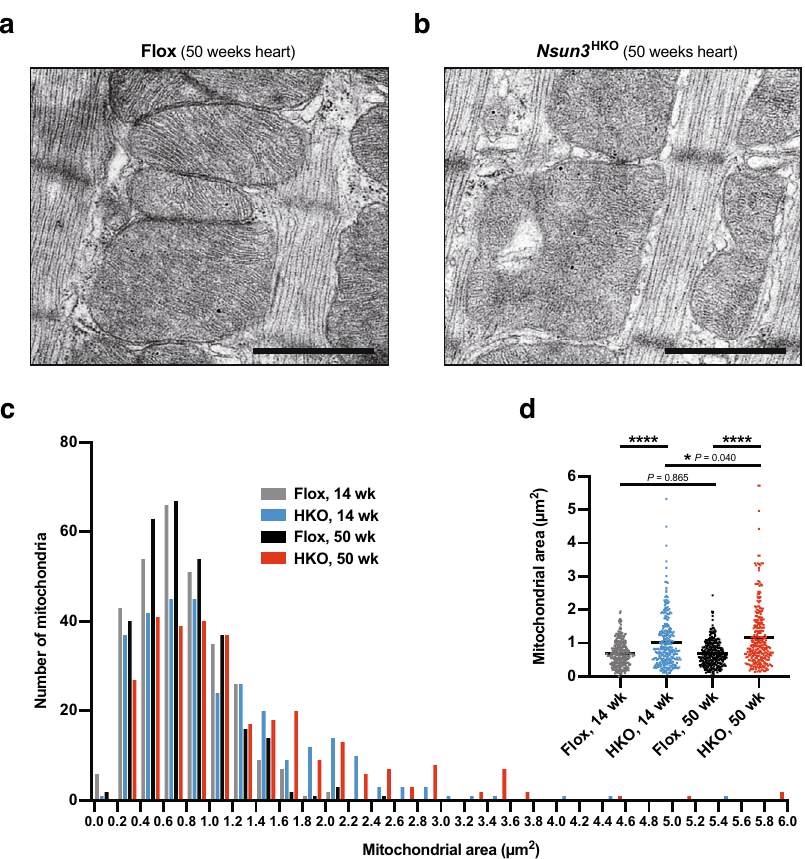
Fig. 4 Morphological abnormalities of Nsun3 HKO mouse heart mitochondria. a , b Representative images of mitochondria in cardiac muscles of 50-week- old Flox mice ( a ) and Nsun3 HKO mice ( b ). Scale bar, 1 μ m. c Histogram showing the size distribution of cardiac mitochondria from 14- or 50-week-old, Flox, or Nsun3 HKO mice. n = 300 mitochondria in each group were analyzed. d Violin plot of the same data as shown in the histogram. The mean mitochondrial areas (Flox 14-wk, 0.690 μ m 2 ; HKO 14-wk, 1.011 μ m 2 ; Flox 50-wk, 0.685 μ m 2 ; HKO 50-wk, 1174 μ m 2 ) are indicated by horizontal lines. **** P < 0.0001 and * P < 0.05 by Mann – Whitney